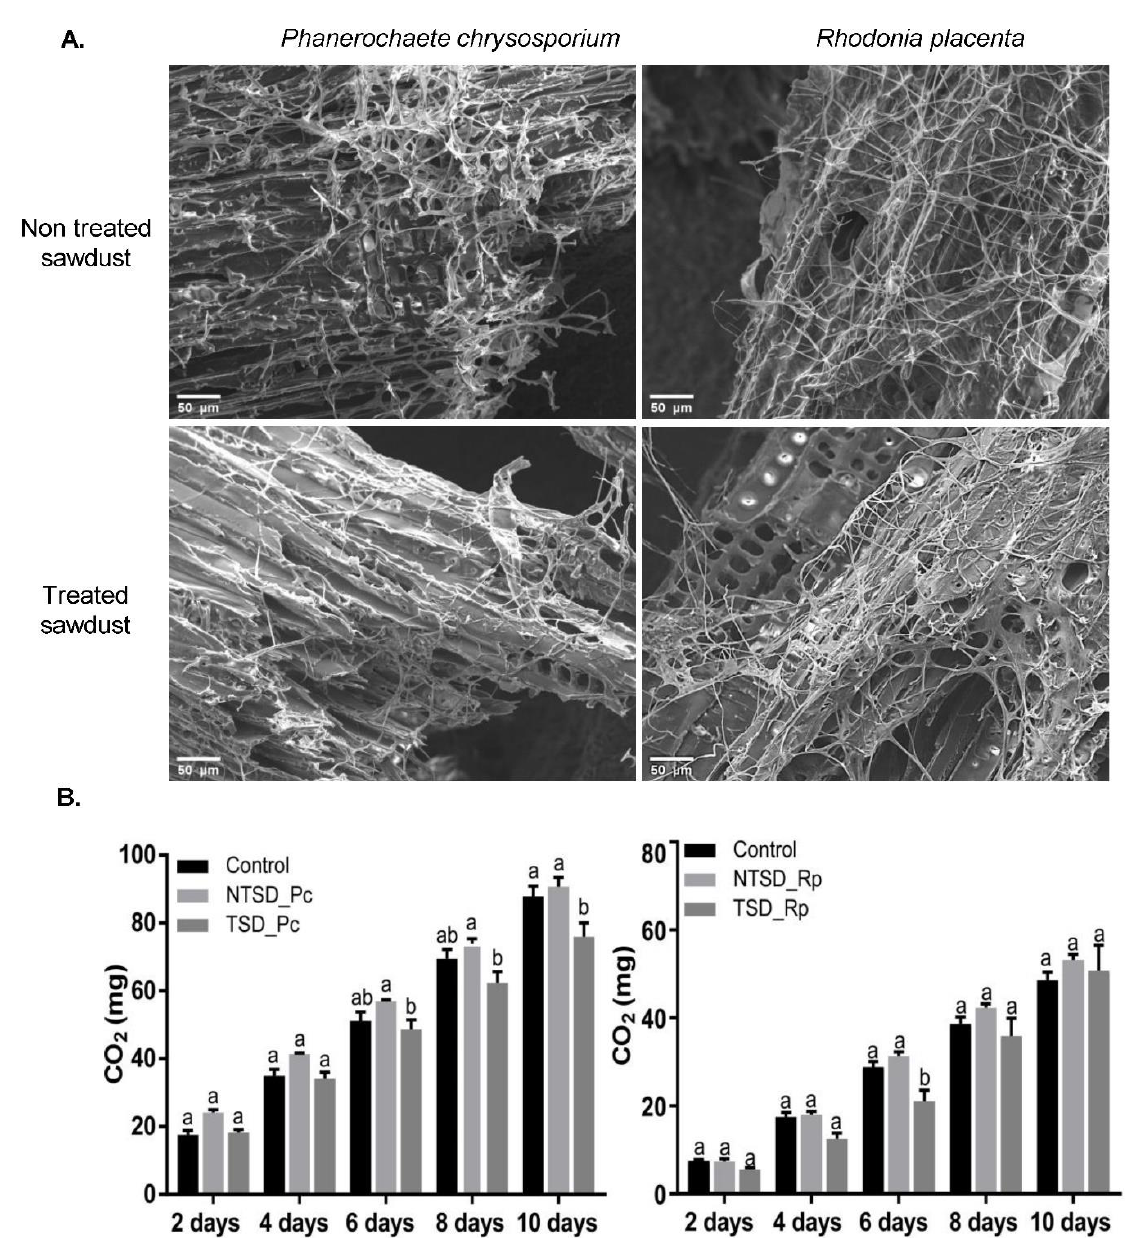
Figure 1. Fungal colonization of non-treated and treated sawdust: ( A ) Scanning Electron Microscopy images of P. chrysosporium and R. placenta colonization of treated (TSD) and non-treated (NTSD) sawdust after 10 days; ( B ) cumulative CO 2 production for P. chrysosporium and R. placenta grown on malt (control), non-treated (NTSD_Pc/NTSD_Rp), and treated (TSD_Pc/TSD_Rp) sawdust over 10 days; mean ± s.e., n = 5; two-way ANOVA and Tukey’s post hoc test ( p -value ≤ 0.05). Identical letters indicate no significant differences in the respiration between treatments at a given time point.